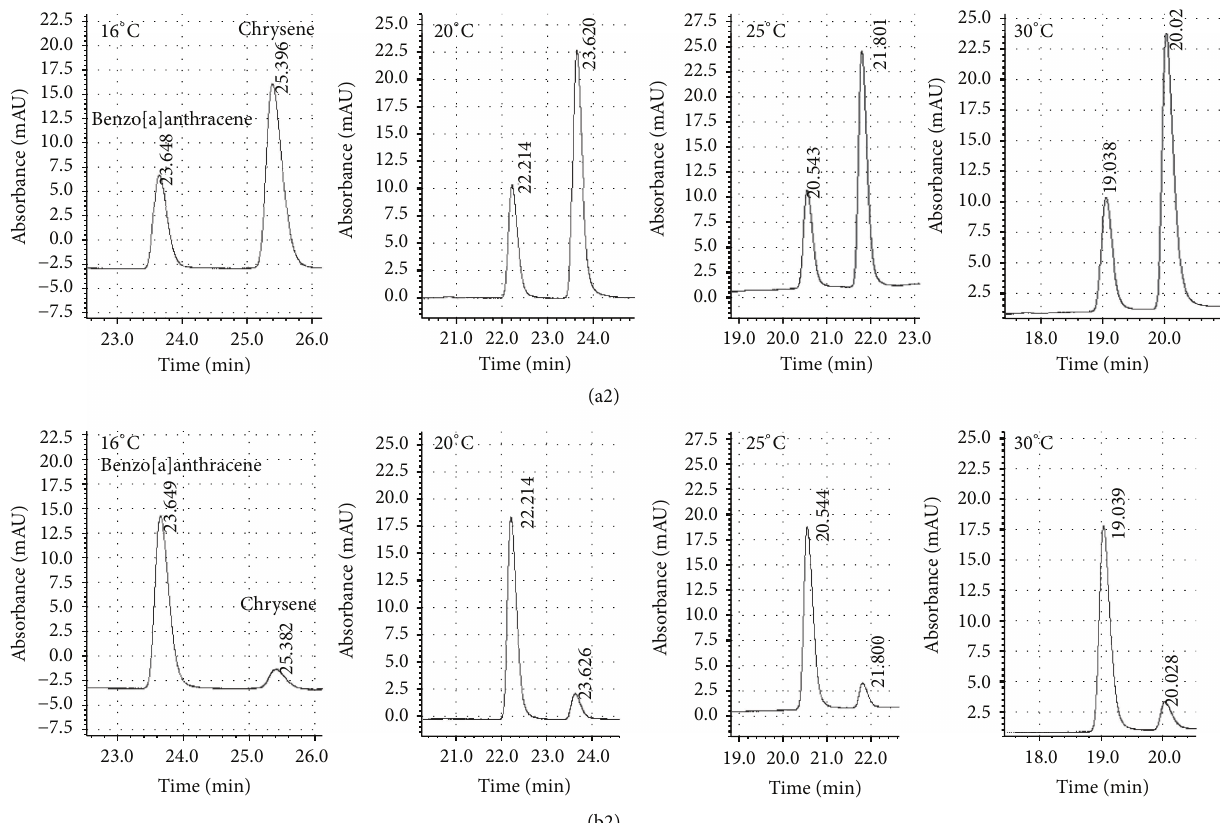
Figure 5: Effect of the temperature on the separation of chrysene and Benzo[a]anthracene using the Supelcosil LC-PAH column; (a2) at 266 nm; (b2) at 286 nm.